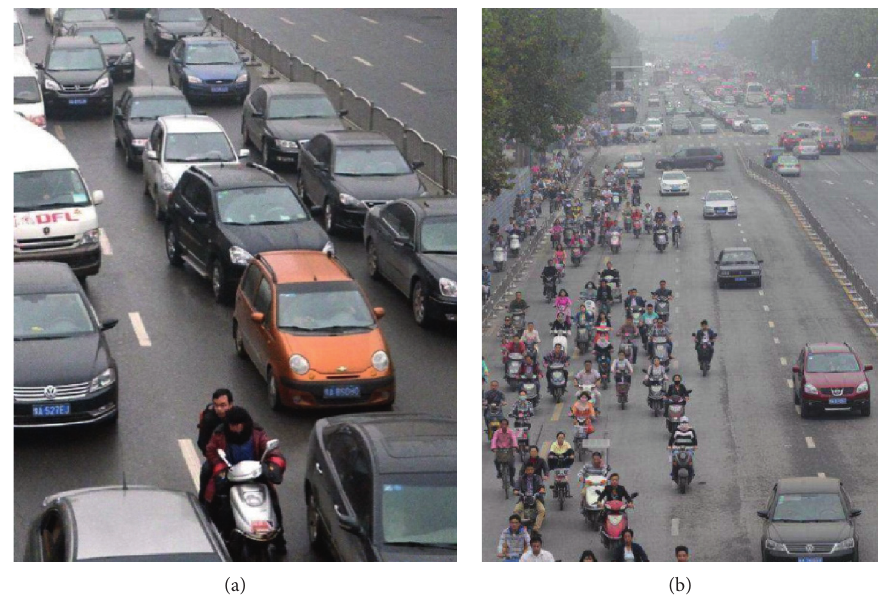
Figure 1: Riding behavior of illegal occupation (IO). (a) One e-bike involves IO. (b) Multiple e-bikes involve IO.